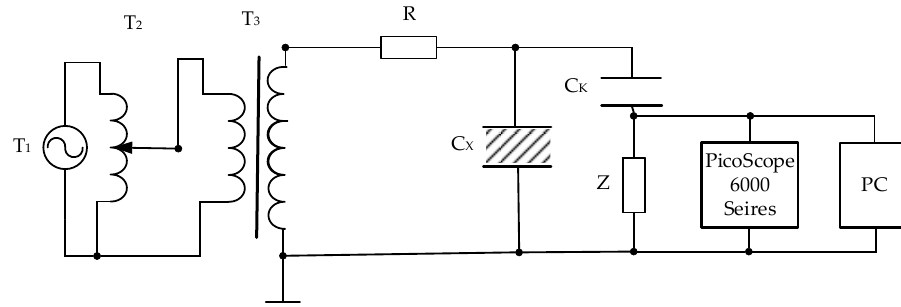
Figure 15. Experimental circuit diagram.